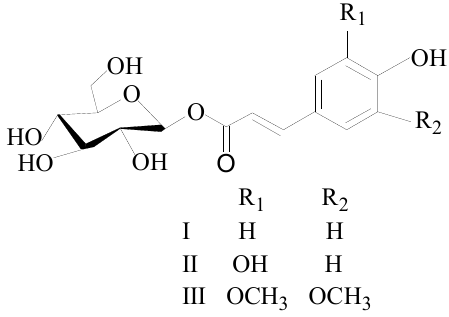
Figure 1. The chemical structure of the three compounds. Ι : β -D-glucopyranose 1-[(E)-3-(4- hydroxyphenyl)-2-propenoat]; ΙΙ : β -D-glucopyranose 1-[(E)-3-(3, 4-dihydroxyphenyl)-2-propenoat]; ΙΙΙ : 1-O-sinapoyl glucopyranoside.